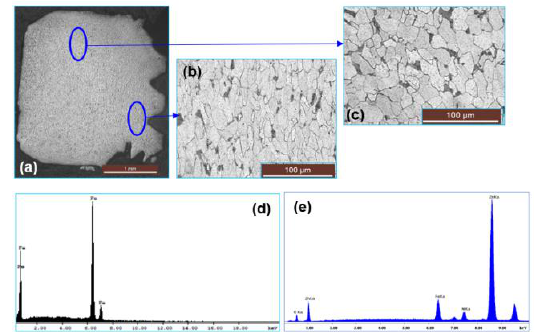
Figure 14: (a-c) Cross-sectional etched optical micrographs of the nut, etchant: 2% nital, (b) EDS analysis of the base material for nut, (c) EDS analysis of the coating for